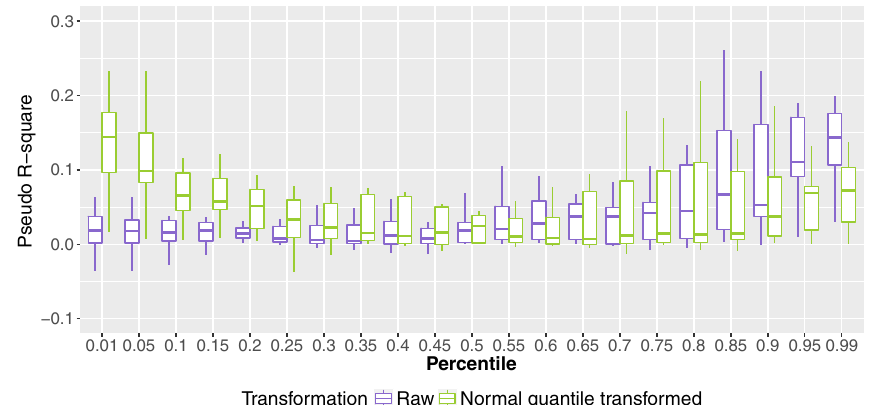
Figure 4. Pseudo- R square for the Mugroso watershed for the coarsest domain and lead times up to